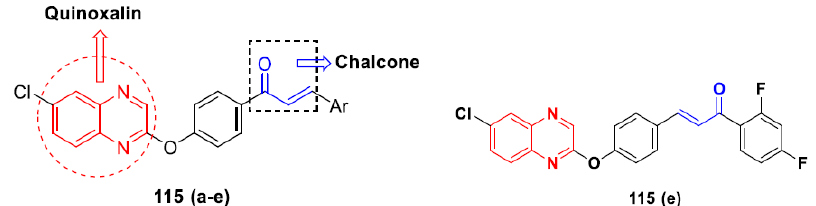
Figure 110. Structure of chalcone-based quinoxalin hybrids and the most promising compound 115e . Table 97. In vitro cytotoxic activities of chalcone-based quinoxaline hybrid compounds [ 115 ( a – e ), 115 ( e